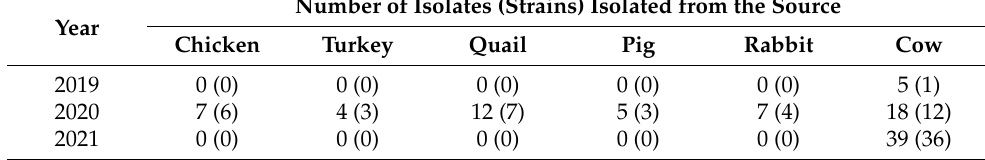
Table 1. Isolates and strains of E. coli isolated from farm animals. Number of Isolates (Strains) Isolated from the Source Year Chicken